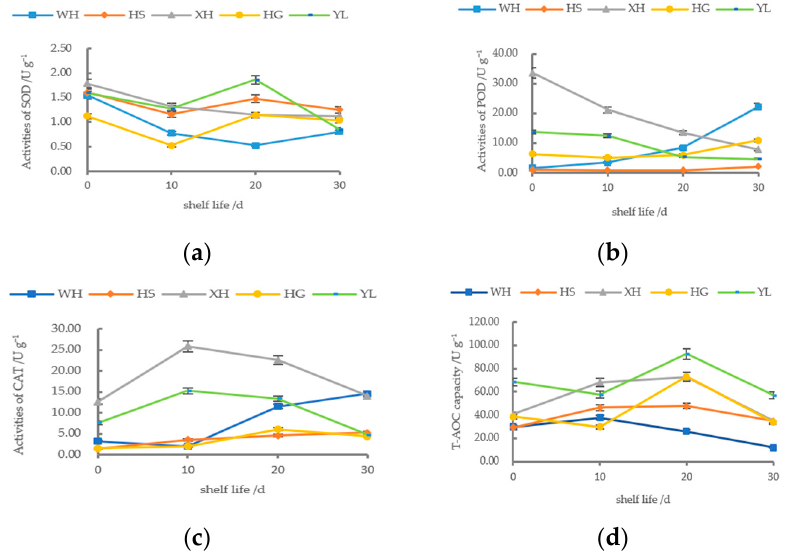
Figure 4. T − AOC and activities of the antioxidant enzymes in the pear peel during the shelf life. ( a ) Activities of SOD, ( b ) Activities of POD, ( c ) Activities of CAT, ( d ) T-AOC capacity.